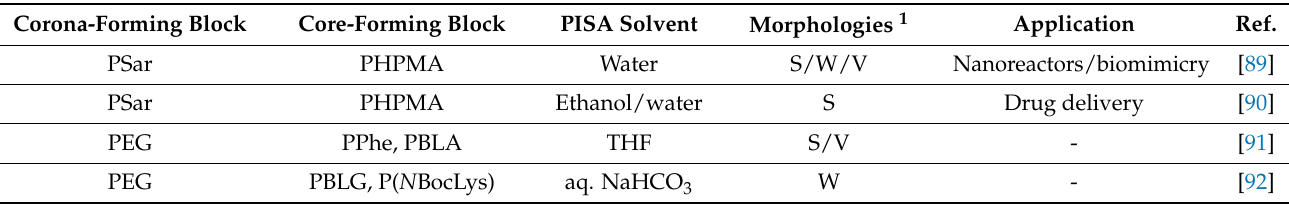
Table 3. Summary of corona- and core-forming blocks, reaction solvents, obtained morphologies, and applications of polypeptide- and polypeptoid-based nanostructures prepared via PISA. Corona-Forming